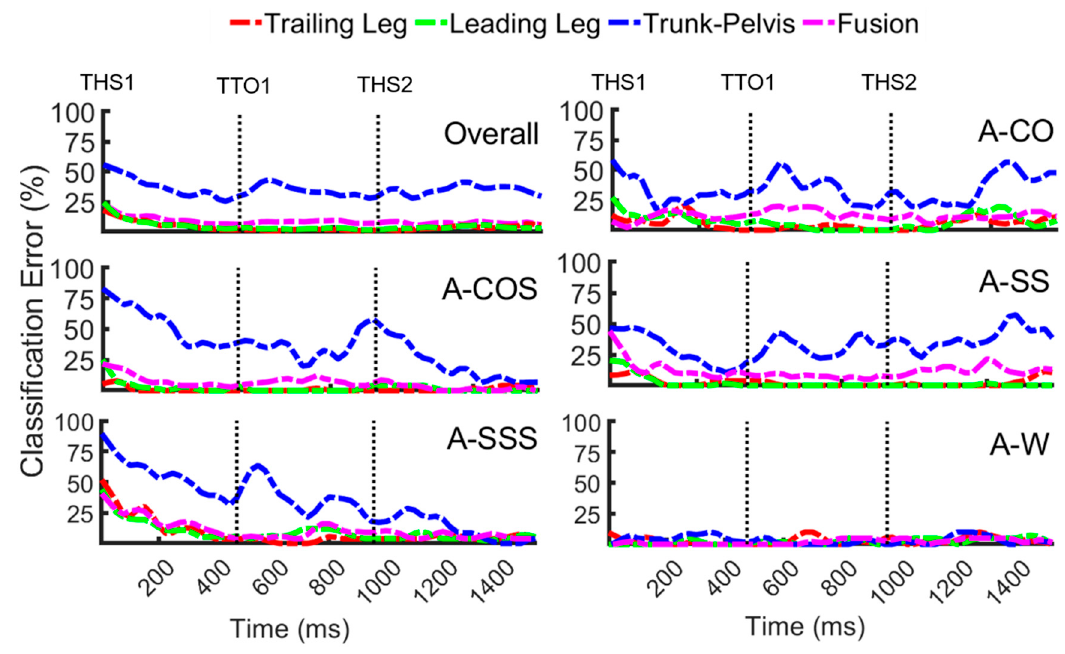
Figure 3. Classification error over time for anticipated locomotor transitions (A-CO, A-COS, A-SS, A-SSS, and A-W) as well as overall error across transitions using biomechanical signals from the trailing leg, leading leg, trunk-pelvis and their fusion. Each trial was initiated with the first trailing leg heel strike (THS1). Subjects entered a locomotor transition at (TTO1), and transition ended with the second trailing leg heel strike (THS2).